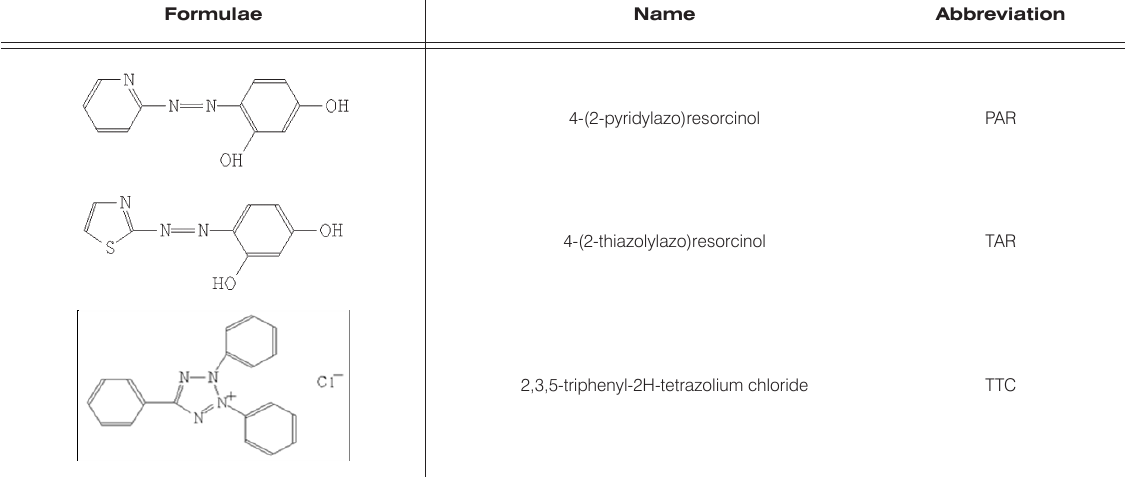
Table 1. Reagents in the present study.